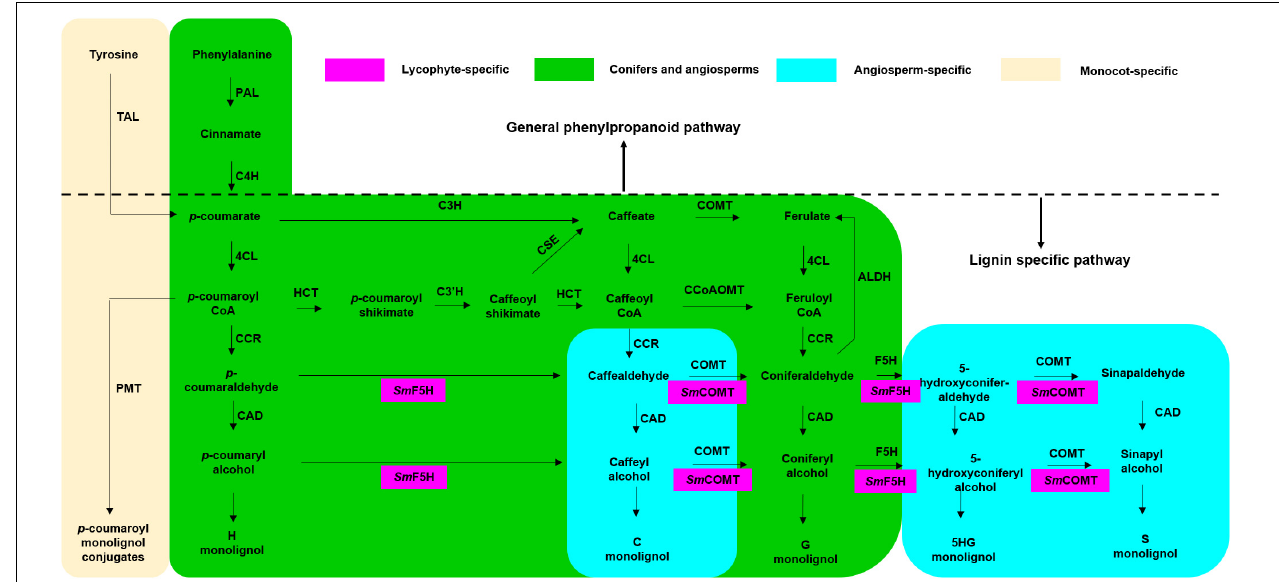
FIGURE 1 | Schematic representation of pathways to produce H, G, and S-monolignols across different plant species. Pathways leading to monolignol biosynthesis include general phenylpropanoid pathway and lignin-specific pathway, which are separated by the dash line. S-lignin biosynthesis in lycophytes occurs in an independent pathway mediated by SmF5H and SmCOMT (highlighted in purple). Some pathways are shared by conifers and angiosperms (highlighted in green) while the others are angiosperm-specific (highlighted in blue). There is also monocot-specific pathway mediated by TAL (highlighted in yellow).